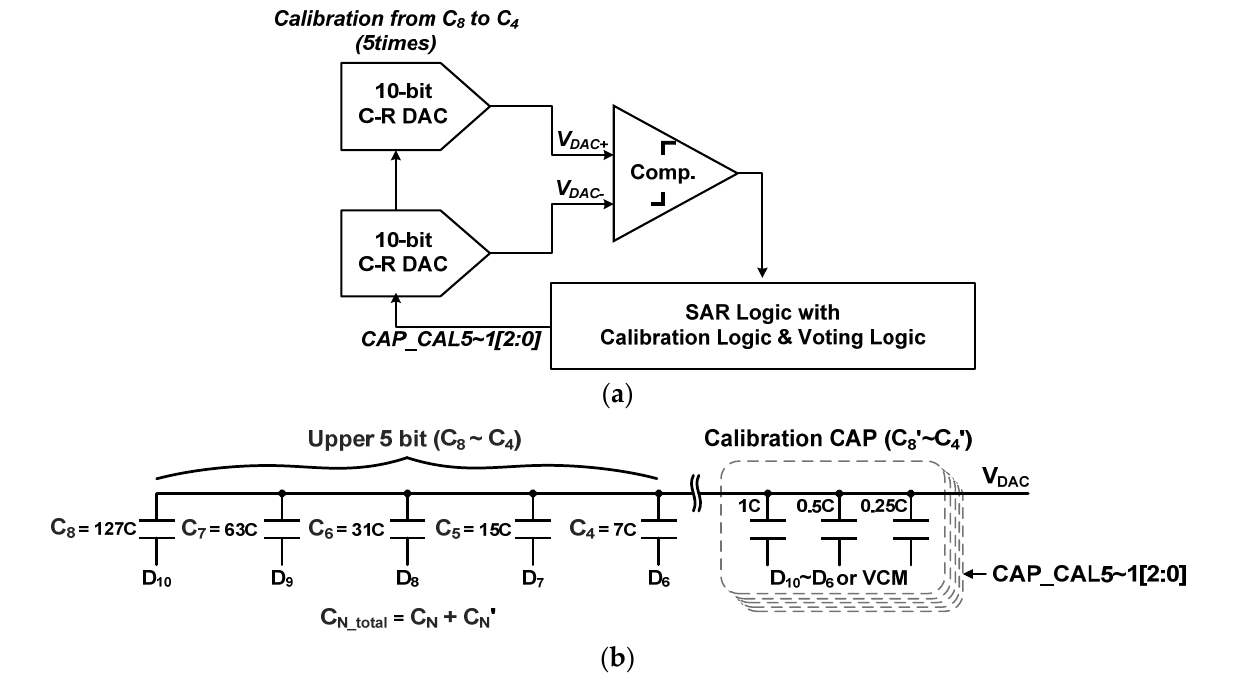
Figure 4. Calibration for upper 5-bit capacitors of C–R DAC: ( a ) concept; ( b ) block diagram.